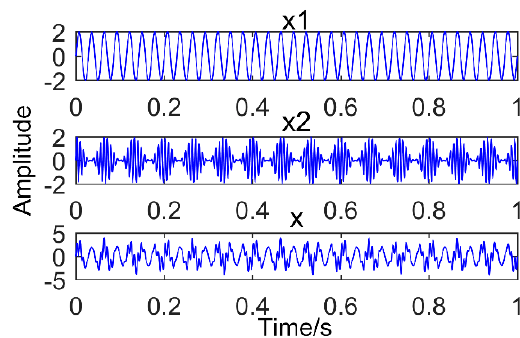
Figure 1. Time domain graph of Simulation signal, x1: sinusoidal signal; x2: Modulation signal; and x: Synthetic